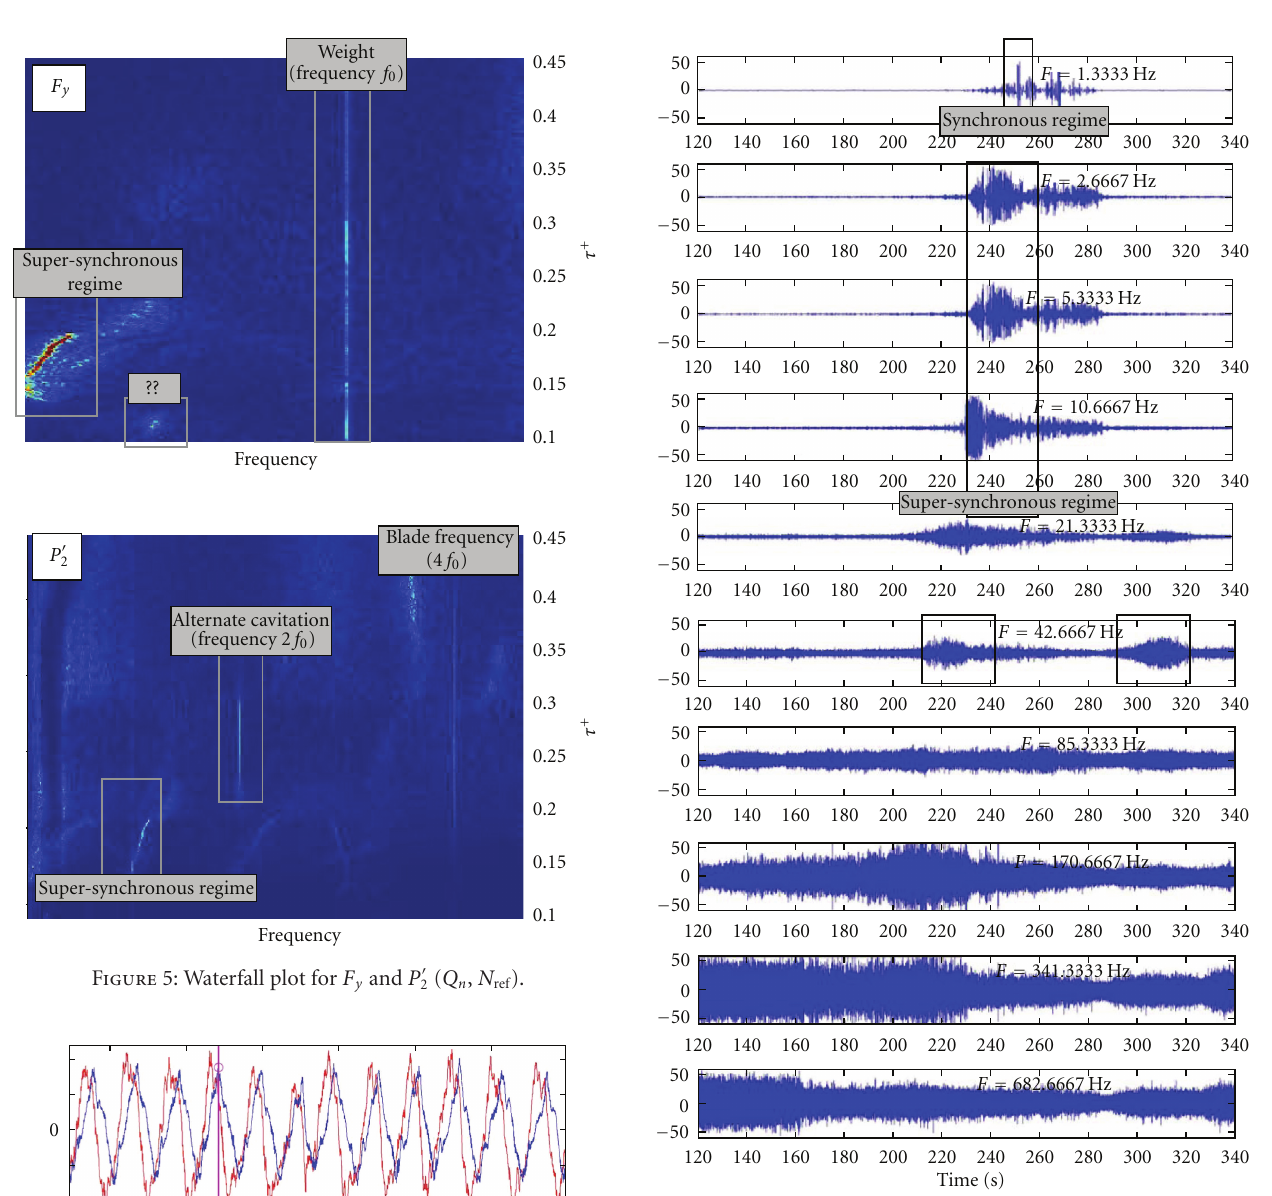
Figure 7: Wavelet decomposition of signal F y